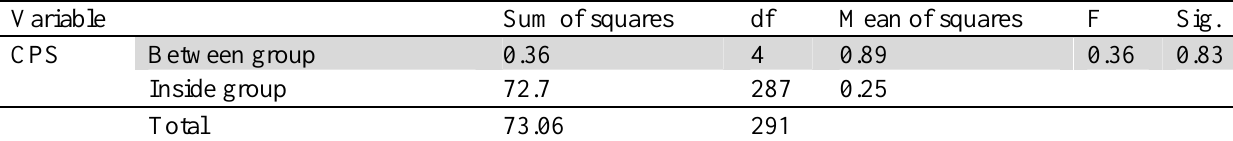
The summary of ANOVA test